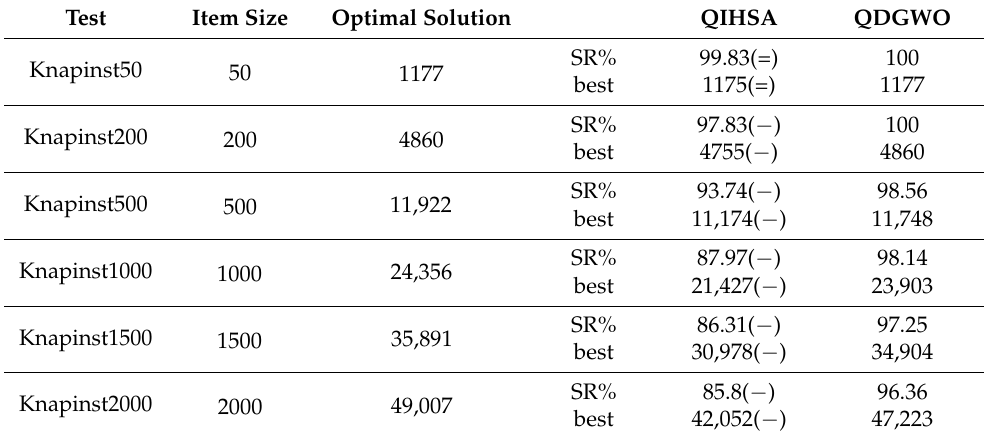
Table 5. Experimental results of QDGWO and QIHSA for 0-1 knapsack problems (Experiment